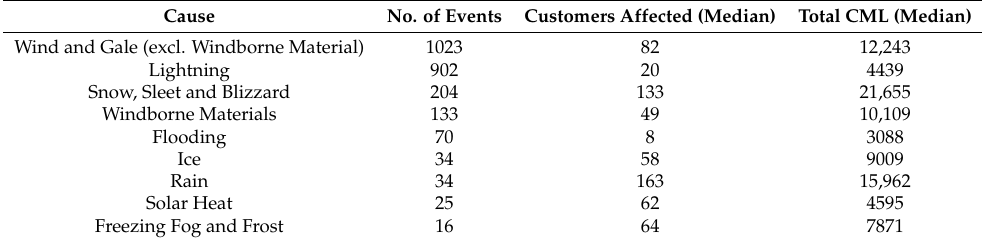
Table 1. HV weather related faults.